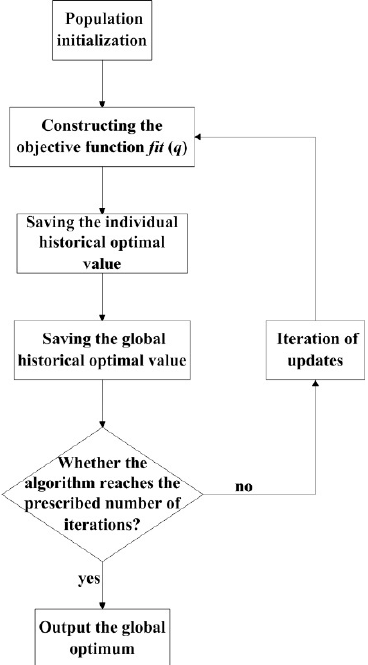
Figure 2. The procedure of MGM model optimized by PSO algorithm.